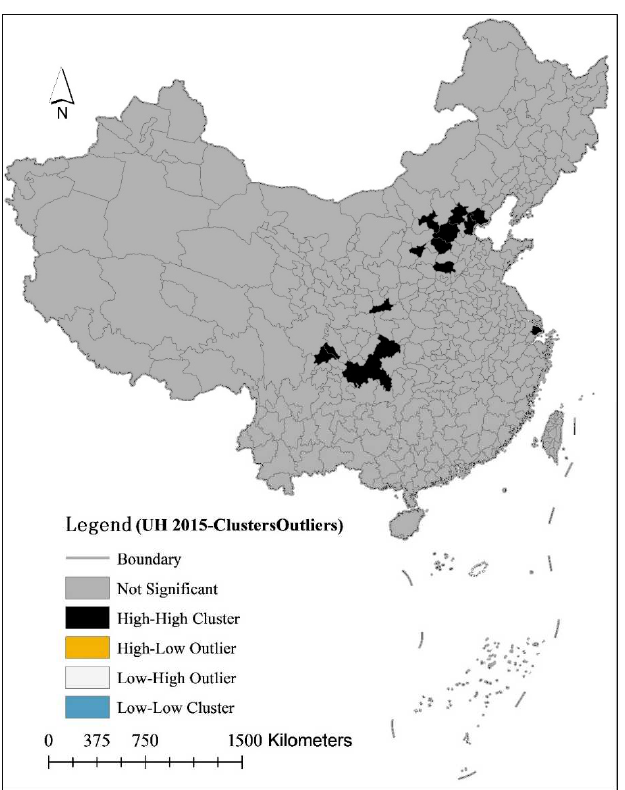
Figure 3. Local spatial autocorrelation of carbon emissions from urban households in China.